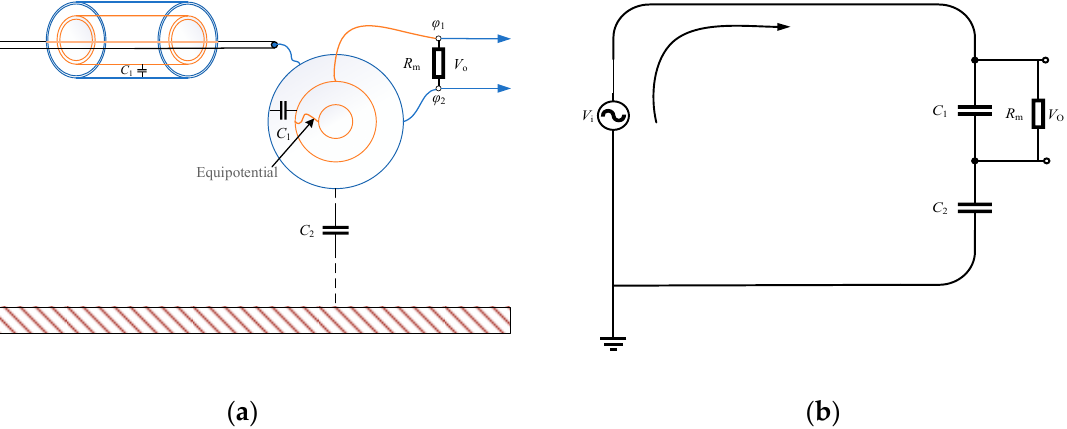
Figure 4. Two capacitance model. ( a ) Principal diagram of two capacitance model; ( b ) Equivalent circuit diagram of two capacitance model.